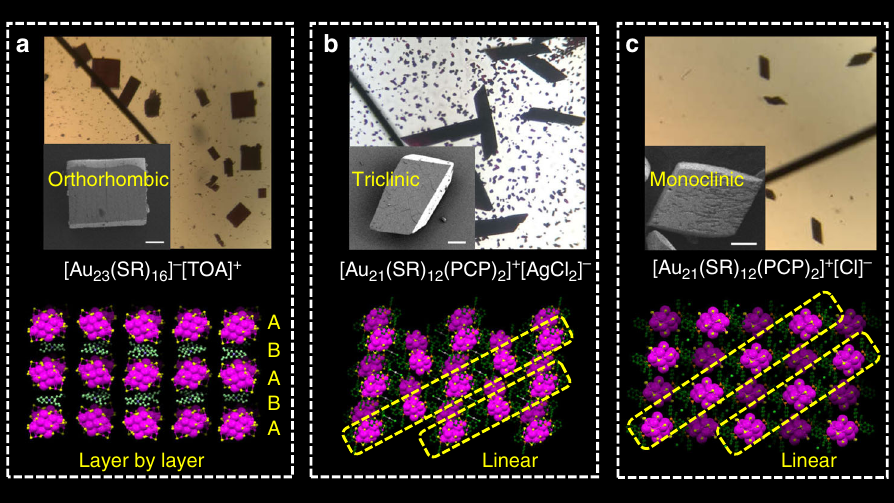
Fig. 3 Hierarchical 3D crystals of the three types of Au NPs. Optical micrographs of the 3D single crystals of [Au 23 (SR) 16 ] − [TOA] + ( a ), [Au 21 (SR) 12 (PCP) 2 ] + [AgCl 2 ] − ( b ), and [Au 21 (SR) 12 (PCP) 2 ] + [Cl] − ( c ) are displayed. Insets are the SEM micrographs of the 3D crystals, scale bar: 50 µ m. Packing of the three types of Au NPs in their single crystals revealed by X-ray diffraction analysis. The [Au 23 (SR) 16 ] − [TOA] + crystal grows in a layer-by- layer manner (ABAB … ) with [Au 23 (SR) 16 ] − in layer A and the counterion [TOA] + in layer B ( a ). In the crystals of the two Au 21 NPs ( b , c ), the NPs are linearly assembled (yellow [Au 23 (SR) 16 ] − [TOA] + , the shape of the single crystal is rectan- [TOA] + in layer B. However, the Au 21 NPs show a totally dif- gular, and the NPs are packed into a base-centered orthorhombic ferent packing mode in which each type of Au 21 (associated with either [AgCl 2 ] − or Cl − ) is linearly assembled along the lattice (Fig. 3a). On the other hand, in the single crystals of diagonal of the {100} plane in the single crystal of [Au 21 (SR) 12 (PCP) 2 ] + [AgCl 2 ] − , the NPs are packed into a triclinic lattice and the shape of the single crystal is a parallelogram [Au 21 (SR) 12 (PCP) 2 ] + [AgCl 2 ] − and along the diagonal of the {010} plane in the [Au 21 (SR) 12 (PCP) 2 ] + [Cl] − case. (Fig. 3b). The packing mode of [Au 21 (SR) 12 (PCP) 2 ] + [Cl] − in the single crystal is also different from the previous two NPs, which Figure 4 shows the details of the 1D self-assembly of each type shows a monoclinic lattice (Fig. 3c). Interestingly, taking a closer of Au 21 NPs in their single crystals, which shows the distinct effects of the counterions. The linear arrangement in the Au 21 NP look at the arrangement of NPs, one can fi nd that the [Au 23 (SR) 16 ] − [TOA] + crystal grows in a layer-by-layer manner crystals is driven by speci fi c interparticle interactions induced by (ABAB … ) with [Au 23 (SR) 16 ] − in layer A and the counterion the phenyl ligands of the surface hooks. Indeed, when zooming in